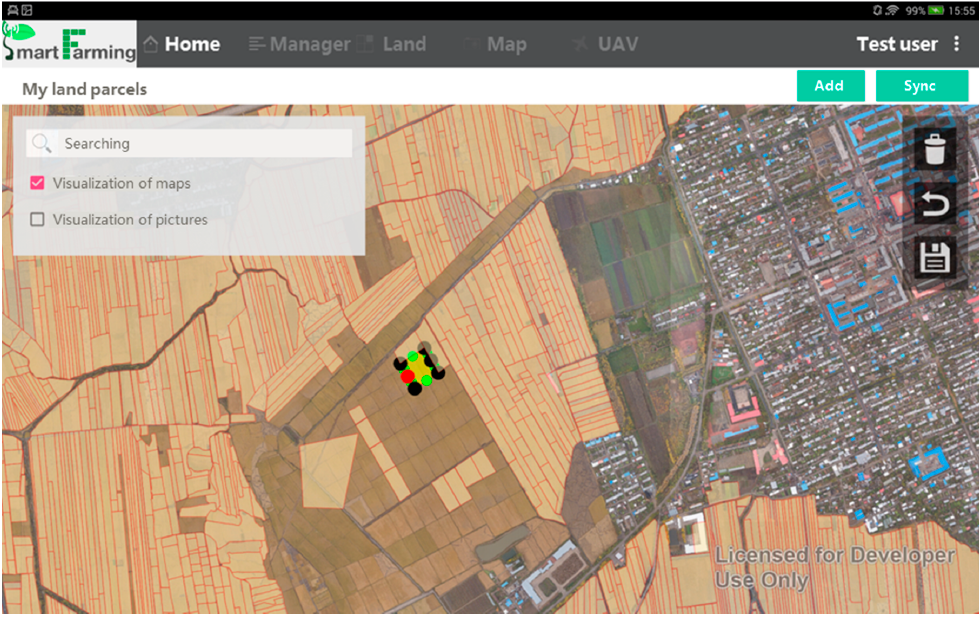
Figure 4. Creating a land parcel polygon based on a manual-drawing process.